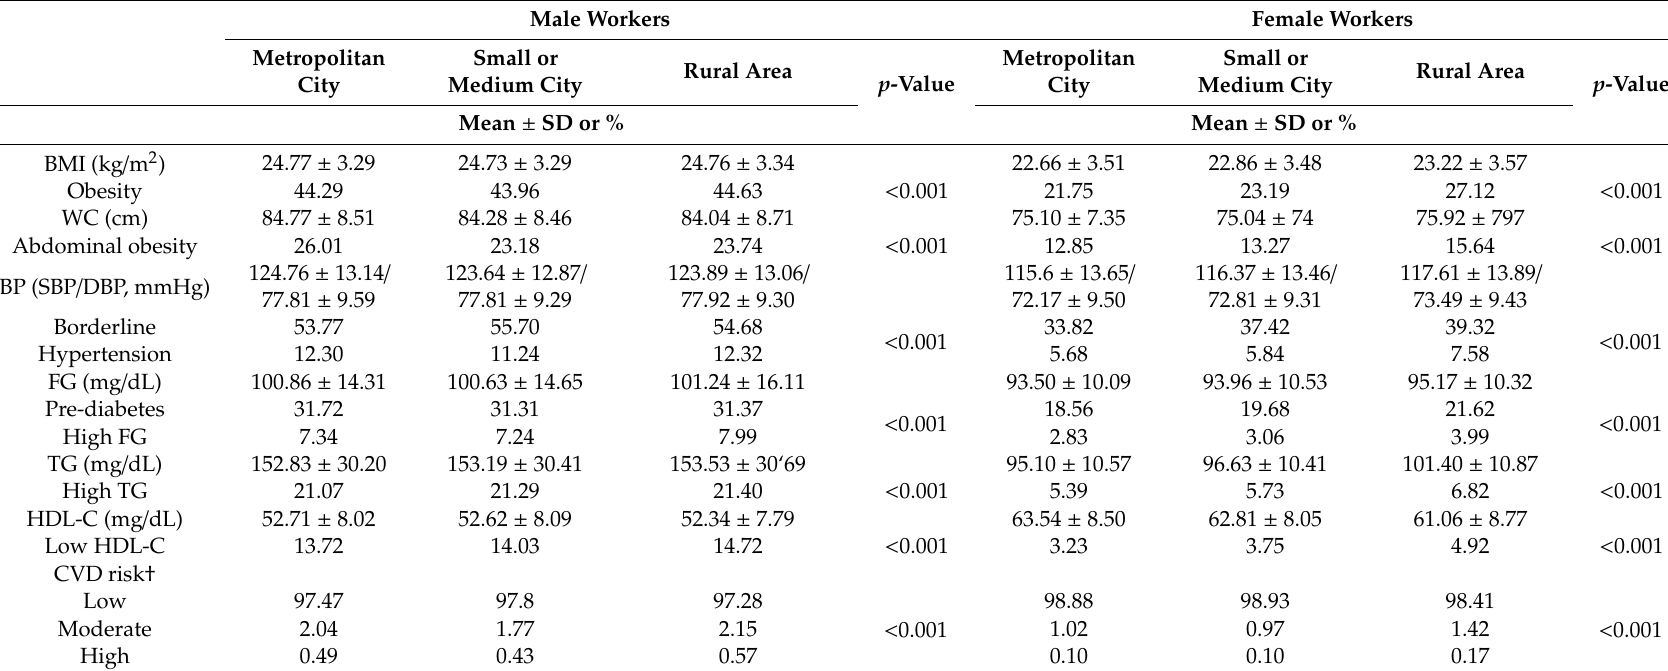
Table 7. Sex di ff erences of CVD-related health status by residential area. Male Workers Female